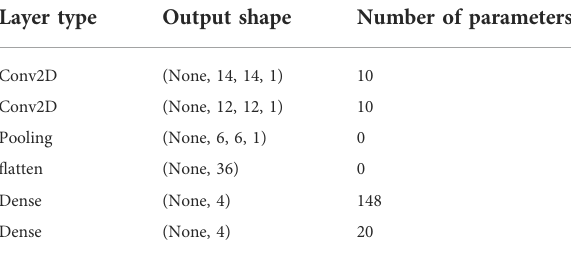
TABLE 3 Structure of the used classical convolutional neural network with 188 parameters. Layer